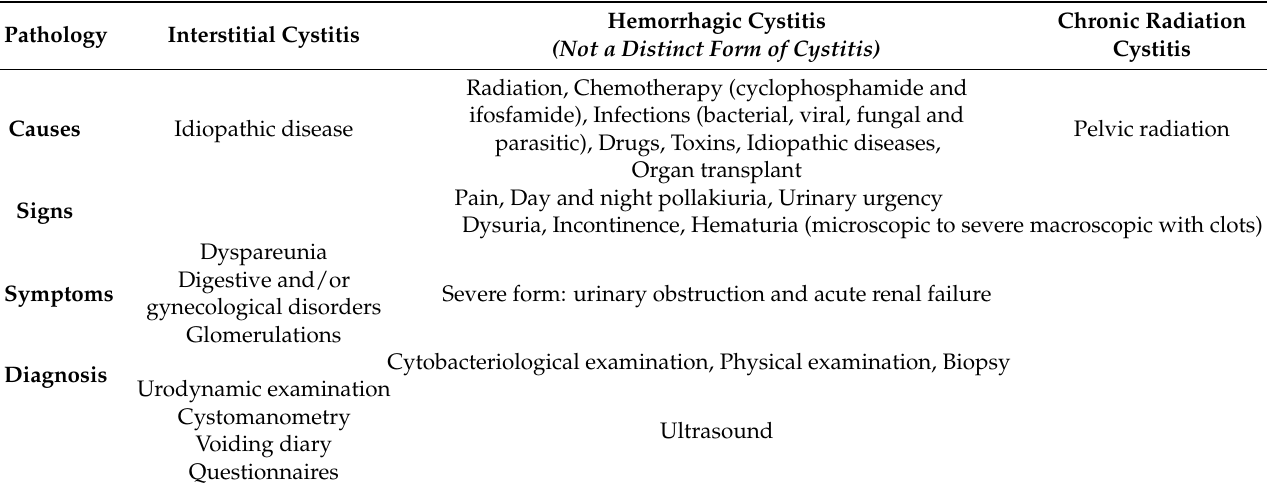
Table 1. Main features of each type of